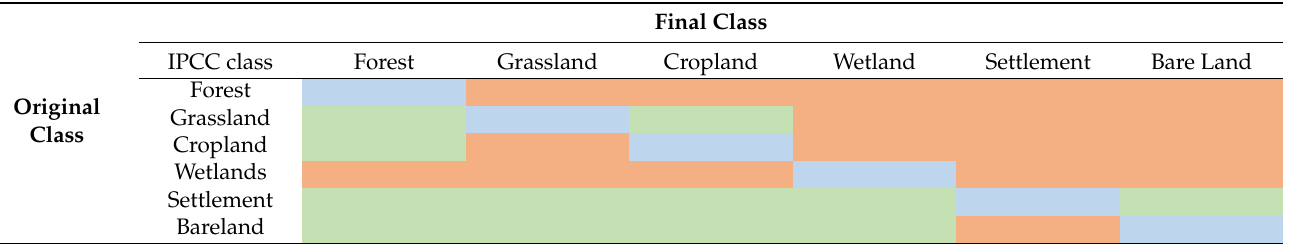
Table 4. Land-cover change transition matrix for six IPCC classes. Boxes are colour-coded as im- proved (green), stable (blue) or degraded (orange).